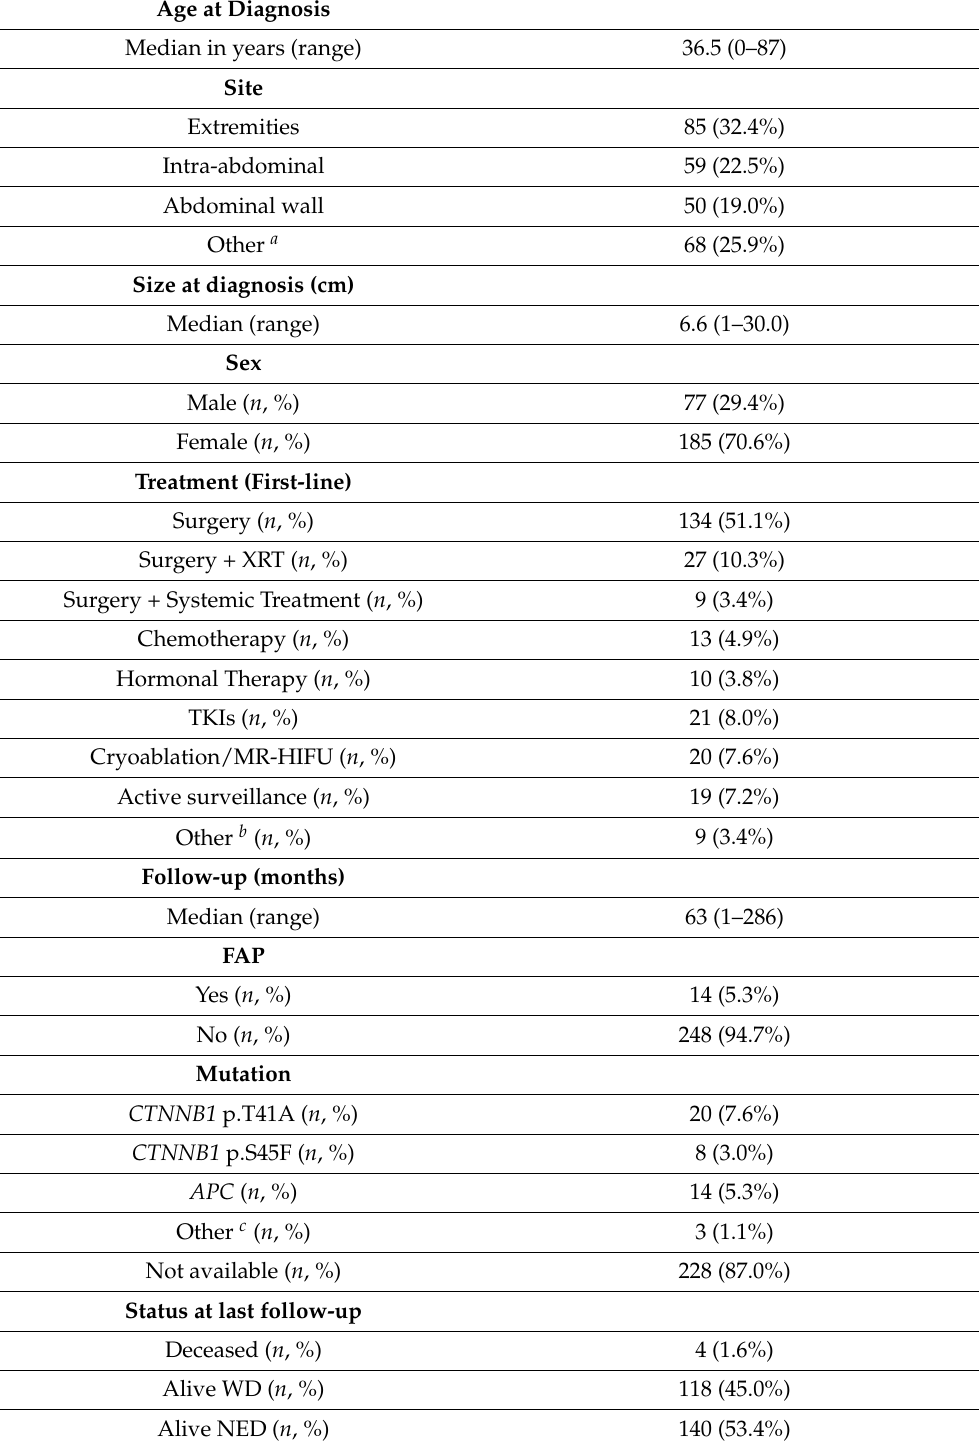
Table 1. Baseline patient characteristics and treatment